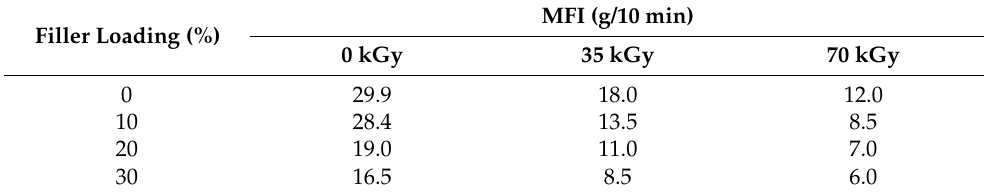
Table 2. Modification of MFI in HDPE/HAp nanocomposites [97].